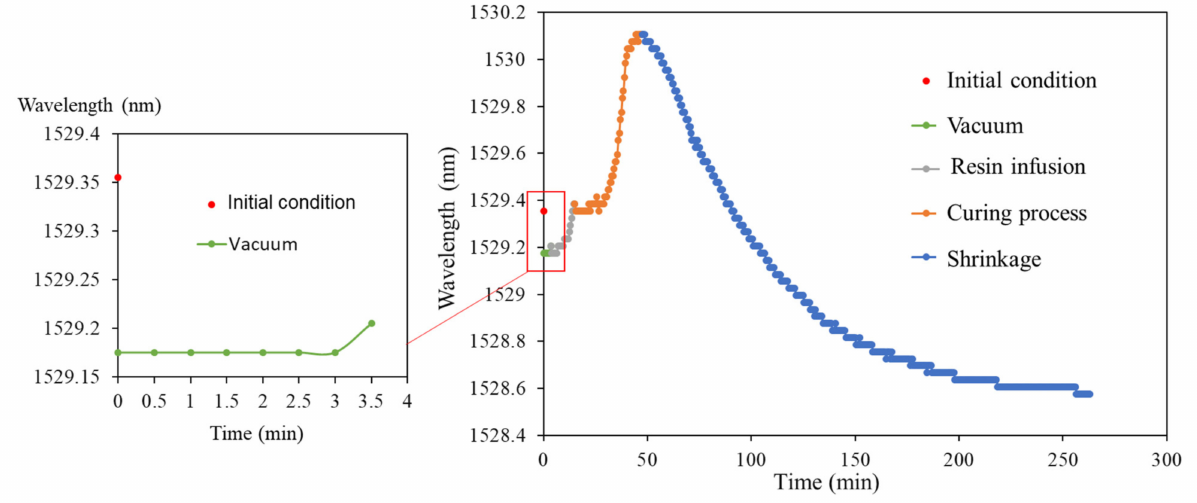
Figure 7. Measurements of the curing of FRP with 30 layers.